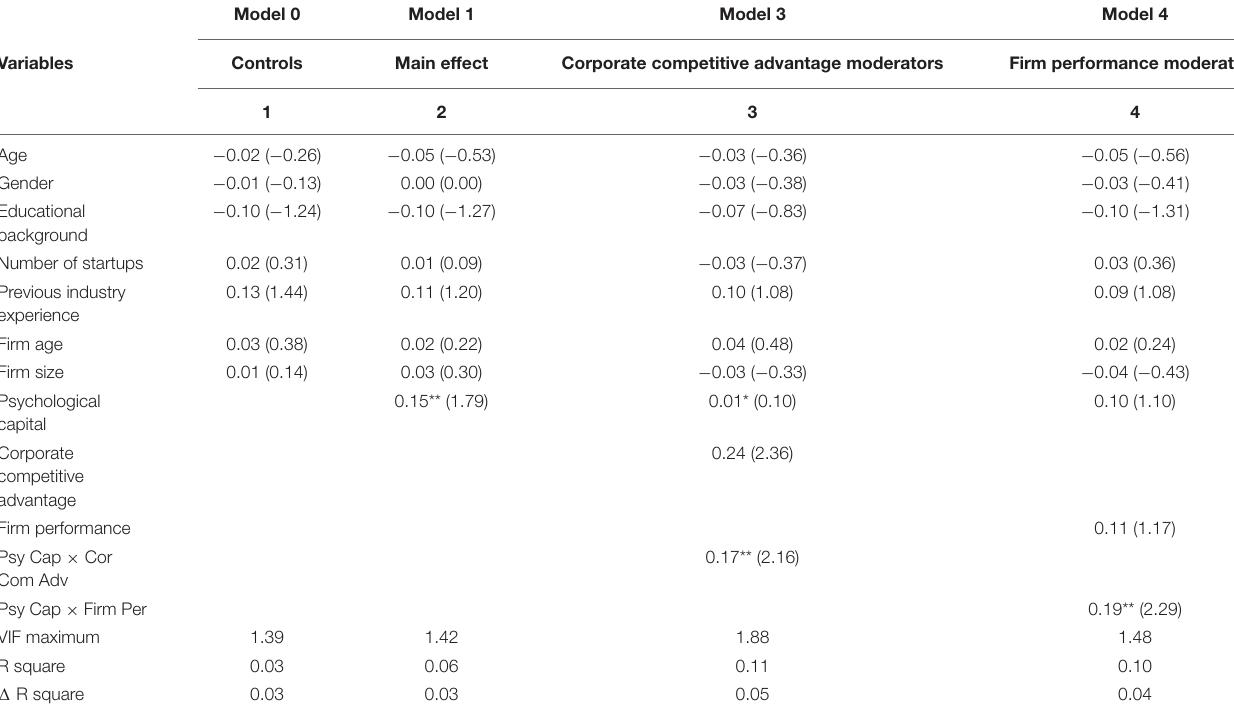
TABLE 4 | Psychological capital and family lending